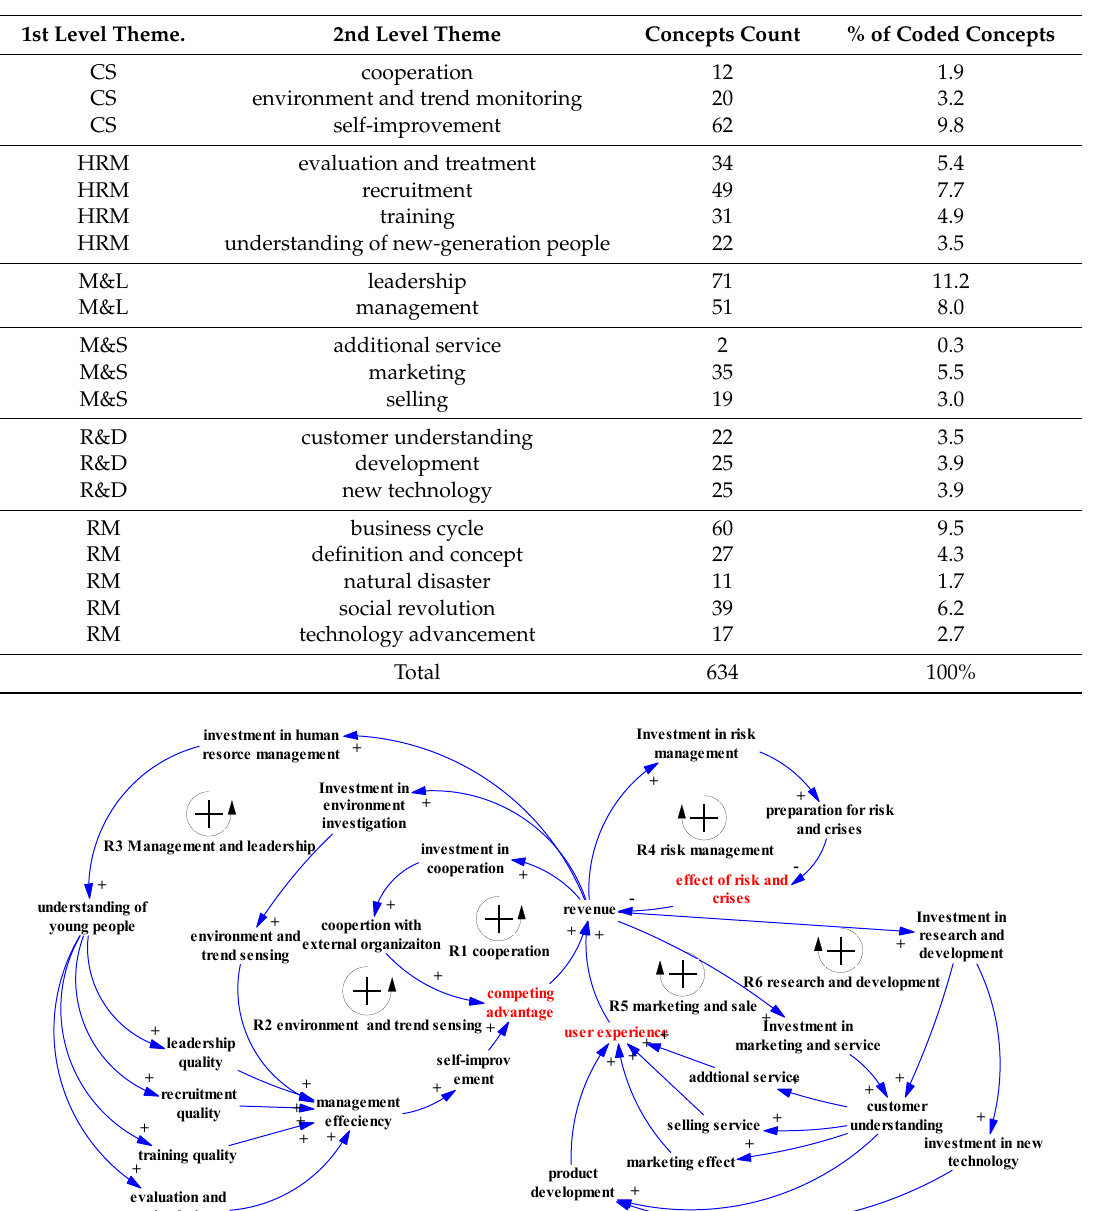
Table 2. The second level of thematic coding.